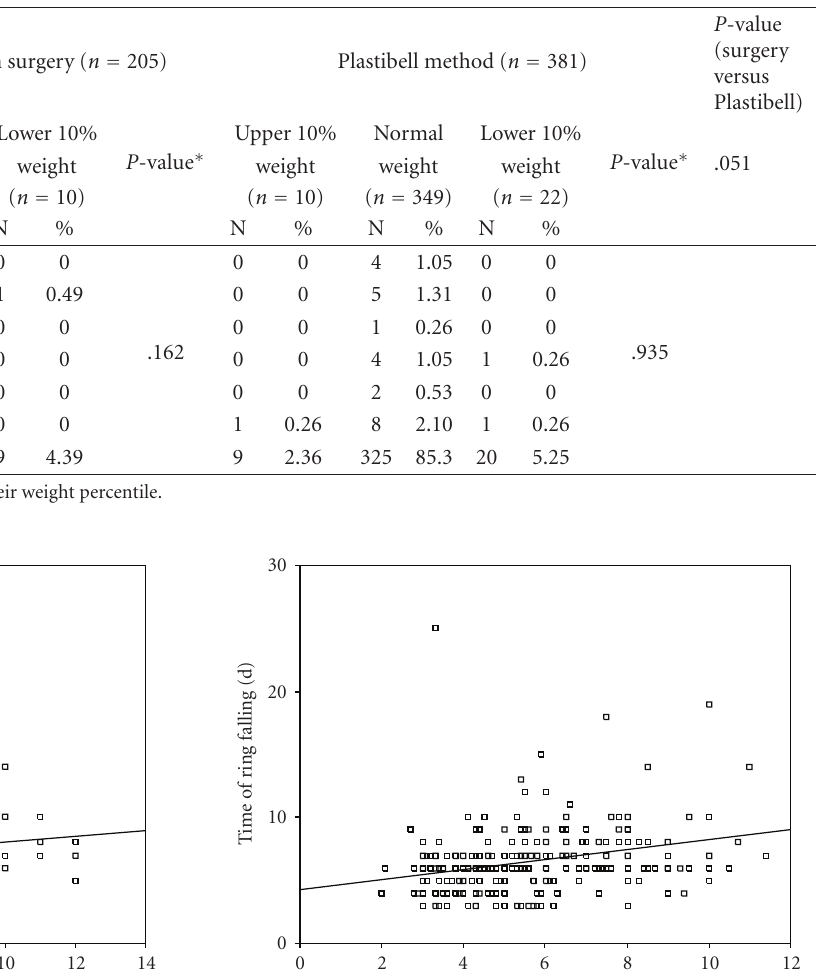
Table 2: Complications of circumcision by conventional dissection surgery and Plastibell methods based on the weight percentile of subjects (chi-square analysis).